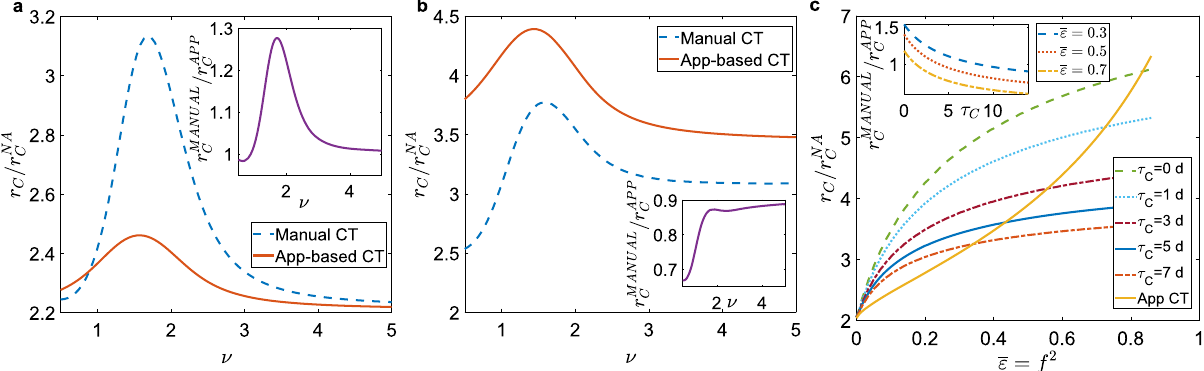
Fig. 4 Effects of limited scalability and isolation delay in manual contact tracing. a Plot, as a function of the exponent ν , of the ratio between the epidemic threshold r C in the presence of CT protocols and the epidemic threshold of the non-adaptive case r NA set ϵ ¼ f 2 ¼ 0 : 1 ( f ≈ 0.316), τ C = 3 days. In the insets we plot the ratio between the epidemic threshold of the manual CT r MANUAL based CT r APP , as a function of ν . b Same plot as a with ϵ ¼ f 2 ¼ 0 : 6 ( f ≈ 0.775), τ C = 5 days. c Plot of the ratio r C = r NA C protocols, setting ν = 1.5 and for several values of τ C . In the inset we plot the ratio r MANUAL distribution ρ ( a S , b S ) is given by Eq.